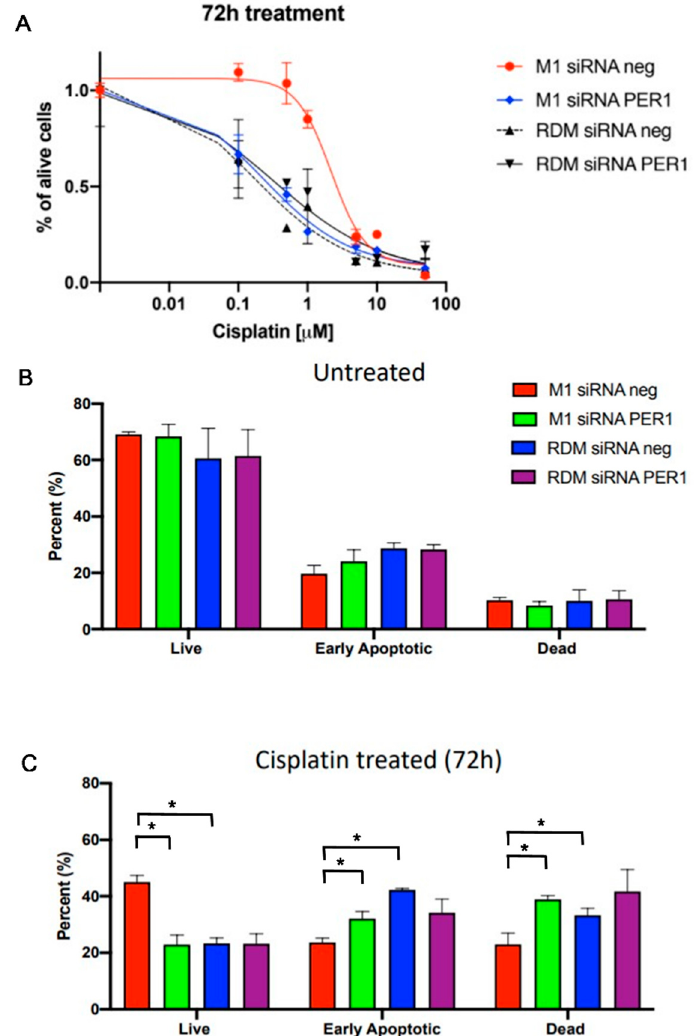
Figure 5. Evaluation of apoptosis changes upon macroH2A1 knockdown and PER1 silencing in basal conditions and upon cisplatin treatment. ( A ) Plot of the concentration–response sigmoidal curve using IC50 values to parameterize concentration–effect curves. ( B ) Apoptosis changes upon macroH2A1 knockdown and PER1 silencing in basal conditions; ( C ) Apoptosis changes upon macroH2A1 knockdown and PER1 silencing with cisplatin treatment. RDM siRNA NEG = siRNA scramble-treated HepG2 cells; RDM siRNA PER1 = siRNA PER1-treated HepG2 cells; M1 siRNAneg = siRNA scramble-treated macroH2A1 knocked down HepG2 cells; M1 siRNA PER1 = siRNA PER1-treated macroH2A1 knocked down HepG2 cells; bars, standard error of mean (SEM); * p < 0.05; three biological replicates were each assayed in triplicate and results were expressed as mean ± standard error of mean (SEM).